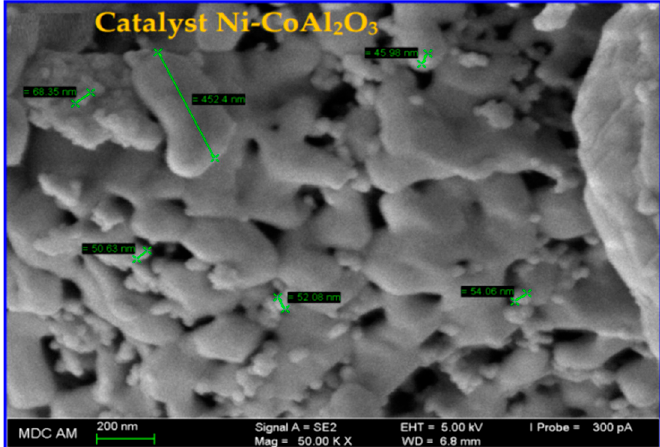
Figure 9. Morphological structure of Ni-CoAl 2 O 3 obtained from SEM.